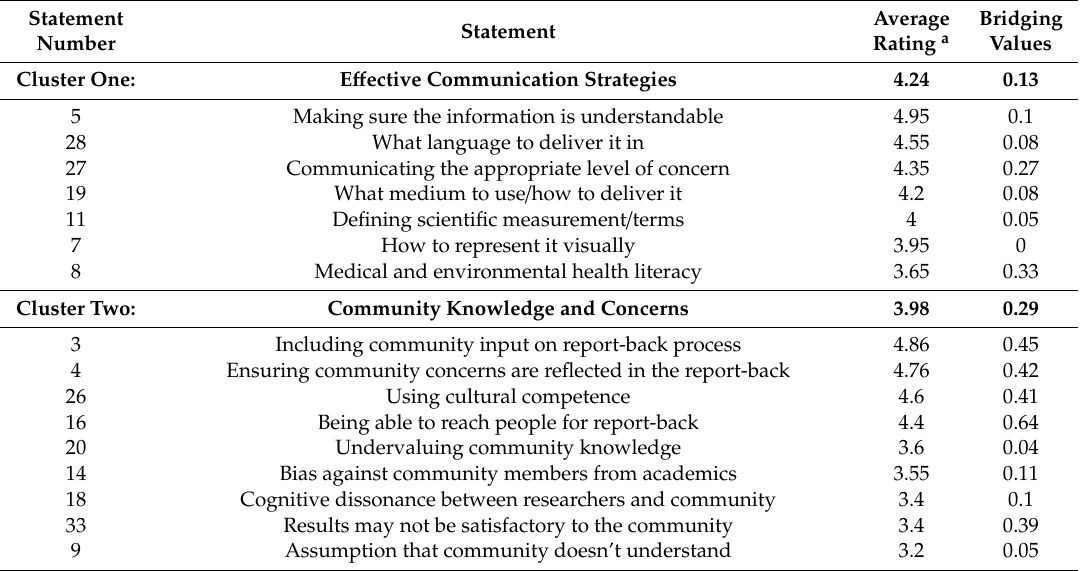
Table 2. Concept Mapping Clusters, Statements, Rating, and